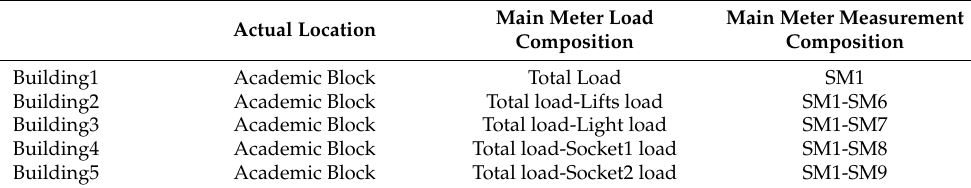
Table 3. The main meter data information of commercial buildings in the synthetic dataset.